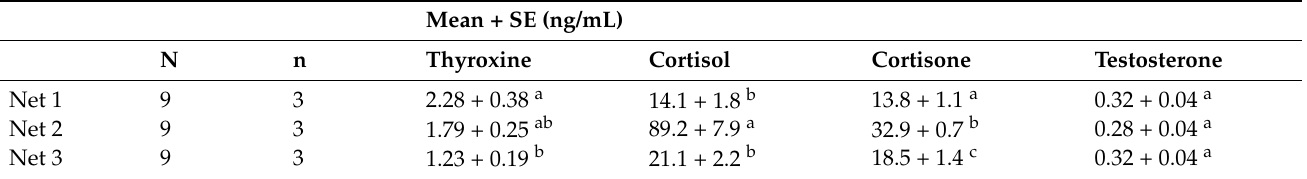
Table 3. The mean value of total thyroxine, cortisol, cortisone, and testosterone in the fish plasma samples from three different nets. Results are reported as mean + standard error